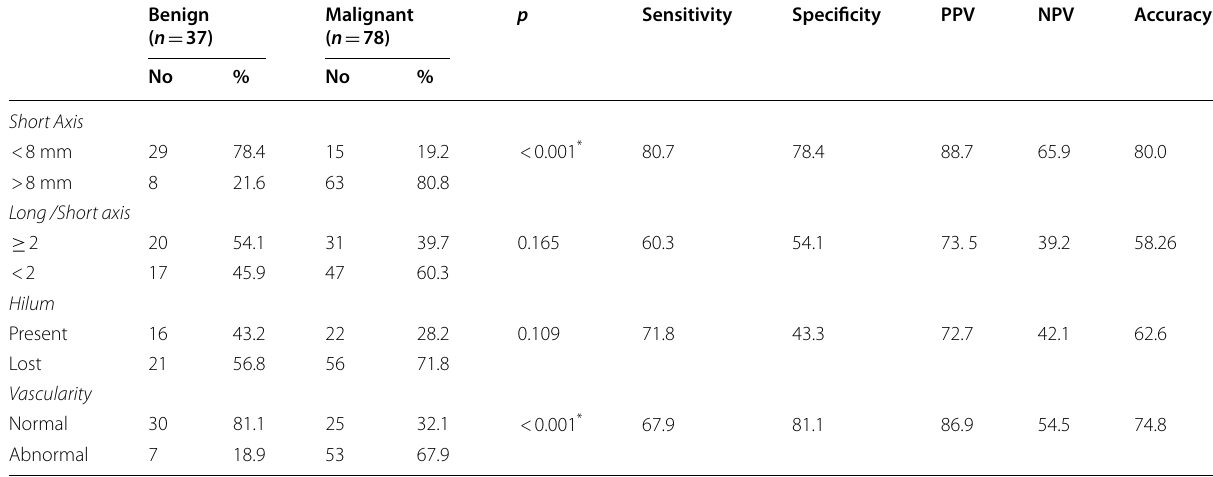
p : p value for comparing between benign and malignant * Statistically significant at p ≤